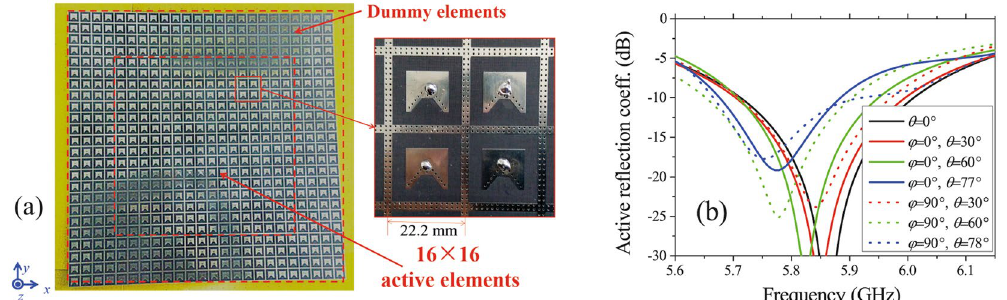
Figure 13. Planar wide-angle scanning array with TMC elements. ( a ) Geometry of the planar array. ( b ) Measured active reflection coefficients of Element (8, 8) corresponding to different scanning angles. The active reflection coefficients in the band of 5.73 GHz–5.86 GHz are below − 10 dB in all the scanning